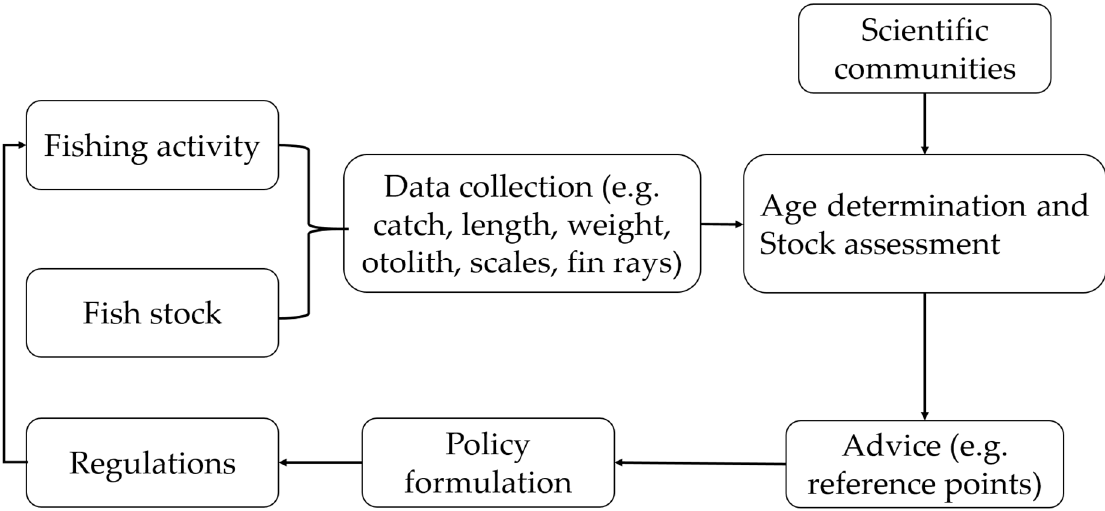
Figure 2. The process of fisheries data collection for age determination methods and stock assessment modelling to provide important advice to develop regulations and policies for sustainable fisheries management.